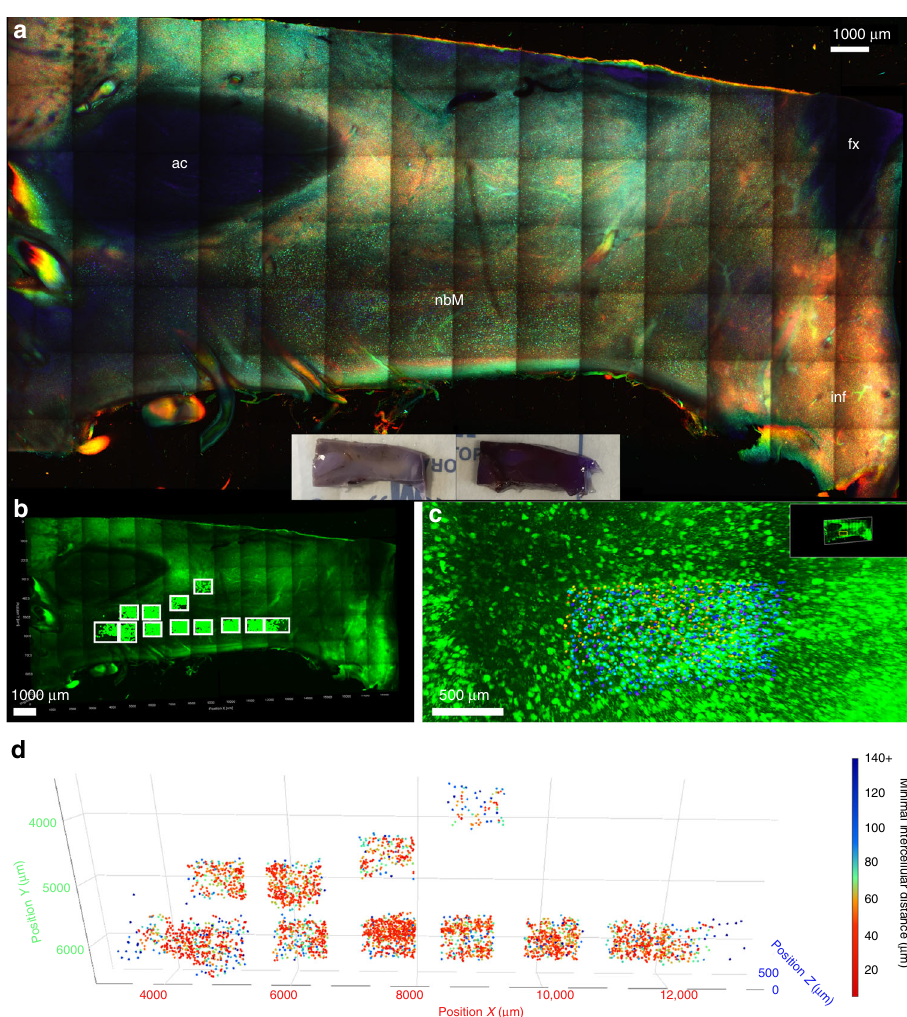
Fig. 5 3D visualisation and quanti fi cation of basal forebrain magnocellular neurons. a Three-dimensional cresyl violet staining for the visualisation of the nucleus basalis of Meynert (nbM) on a 10.8 mm-wide, 5.5 mm-tall, 2.5 mm-thick basal forebrain block (imaging Z-depth = 1120.00 µ m). Tissue block was delipidated with SDS for 3 days and stained with cresyl violet for 3 days (gross appearance shown in inset). Image on bottom left showed magni fi ed view of selected areas from top image. Z-positions of the quanti fi ed and annotated neurons were colour-coded according to the reference bars, where the numerical values indicate the distances from the imaging objective for each end of the spectrum (bottom right). b – d Quanti fi cation of magnocellular neurons in region of interests highlighted in b (white boxes), where the coordinates of each neuron were marked and annotated ( c ). d 4D scatter plot of all 3528 neurons, the distance of each neuron to its nearest neighbour was calculated and represented with colour coding. More detailed statistics were provided in Supplementary Figure 15. ac anterior commissure, fx fornix, inf infundibulum, nbM nucleus basalis of Meynert